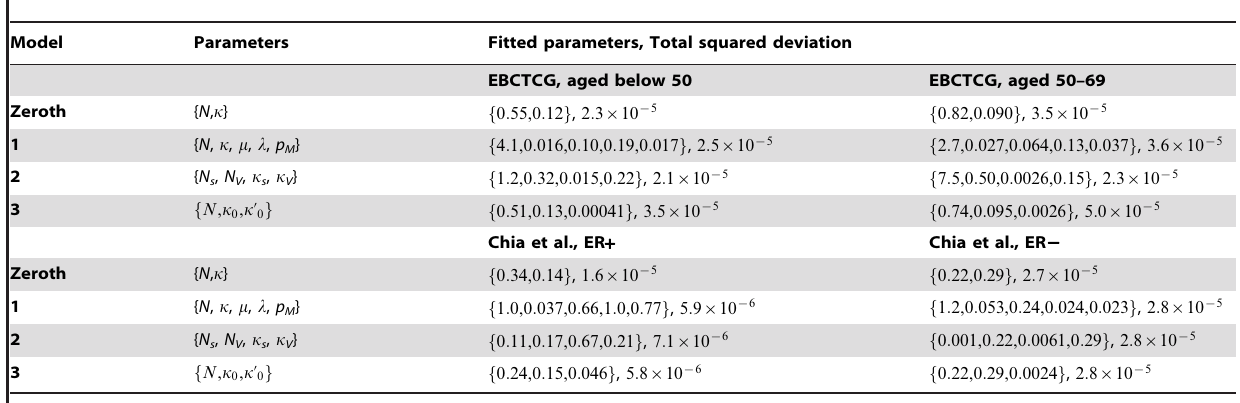
Table 2. Models fitted to relapse